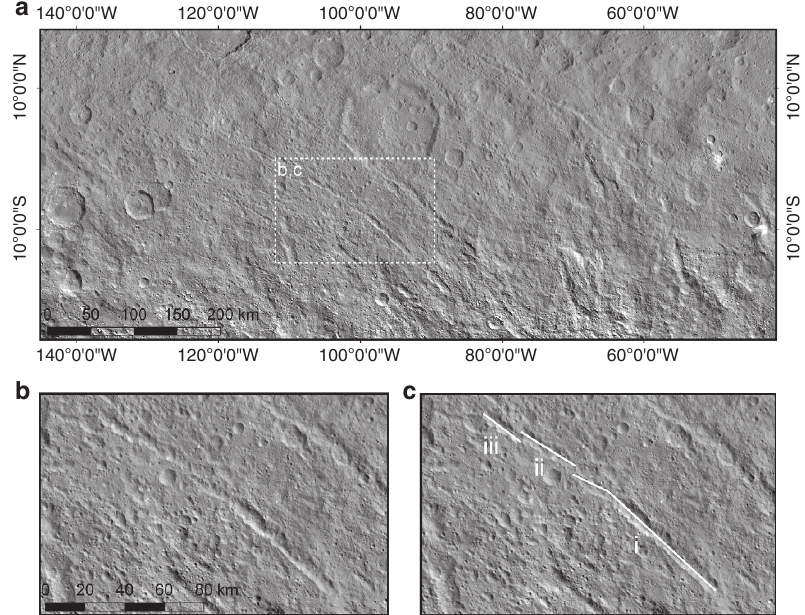
Figure 9 | Pit chains south-west of planitia B. ( a ) Overview image of the set of pit chains whose pole plots in planitia B. ( b , c ) The blank ( b ) and annotated ( c ) inset images show part of the pit chain in the inset box in detail. The surface expression of the pit chain takes the form of merged pits in segment i while individual pits are still observed in segment ii and iii. The segments i, ii and iii are staggered/offset from one another, forming an en echelon pattern that is characteristic of